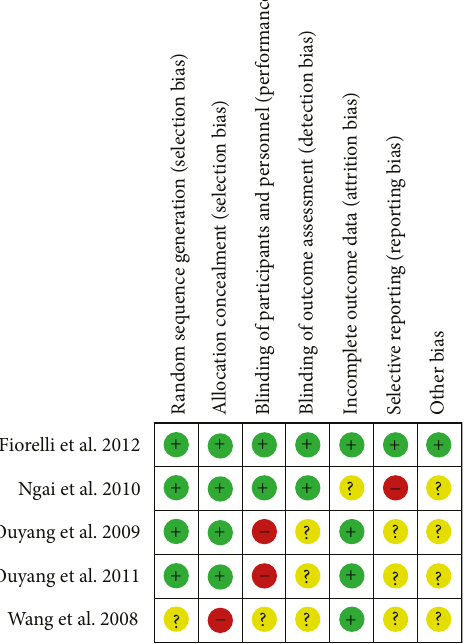
Figure 3: Risk of bias in the individual